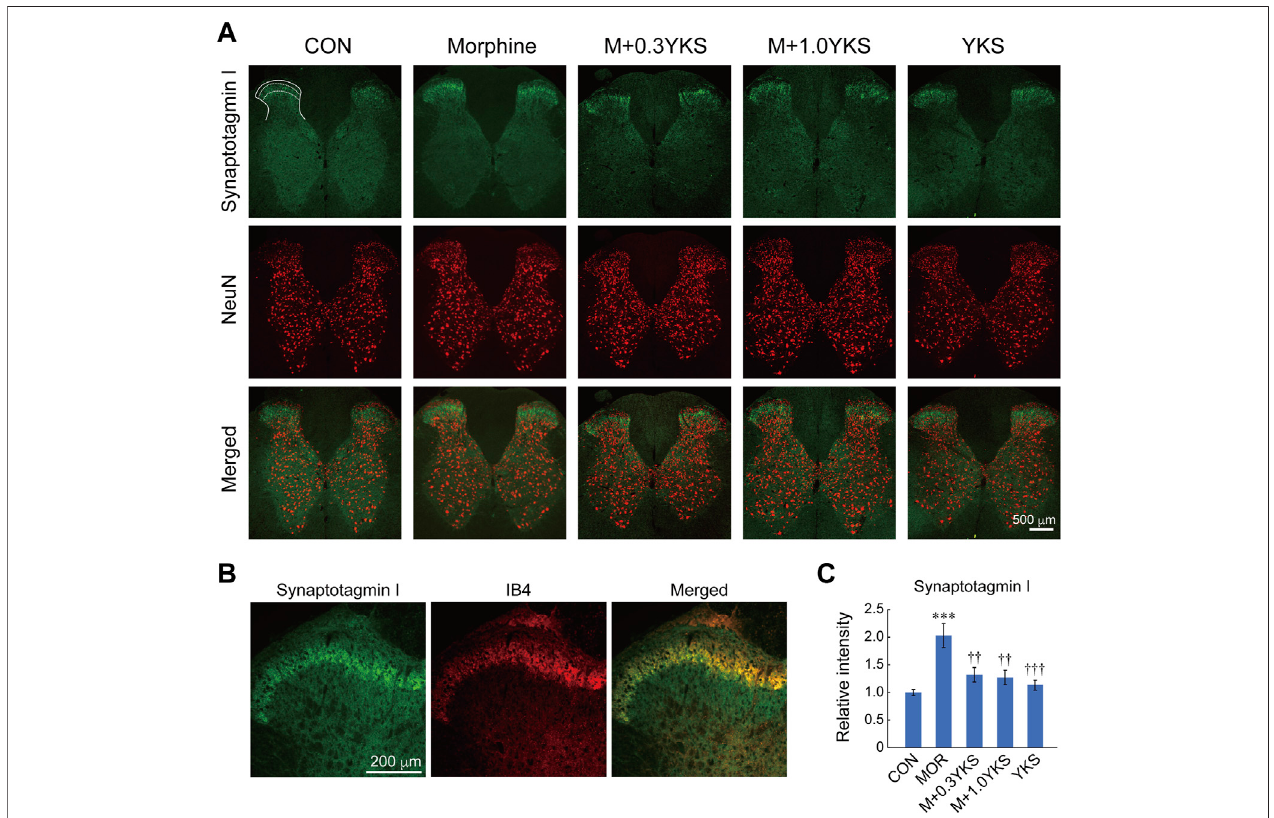
FIGURE4| MorphineincreasedtheexpressionofsynaptotagminIinthelaminaIIofthespinalcorddorsalhorn,andYKSinhibitedtheincrease. (A) Synaptotagmin I-positive presynaptic terminals (Green) were observed especially in the lamina II of the dorsal horns. Neural cells were visualized by anti-NeuN antibody (Red). Merged images were also shown. White bar = 500 μ m. (B) Magni fi ed images for synaptotagmin I and IB4 in the dorsal horn. Green: synaptotagmin I; Red: IB4. White bar = 200 μ m. (C) Quanti fi ed data for the immunoreactivities of synaptotagmin I in lamina II of the dorsal horn. The mean immunoreactivity of synaptotagmin I in each section was determined in the synaptotagmin I-expressing lamina II region [The area bounded by two dashed and solid lines in (A)]. The spinal cord sections were obtained from three rats in each group. The number of (sections and dorsal horns) determined in this experiment were: CON (16 and 32); Morphine (17 and 33); M+0.3YKS (15 and 29); M+1.0YKS (16 and 30); YKS (23 and 42). *** p < 0.001 vs CON group; †† p < 0.01, ††† p < 0.001 vs Morphine